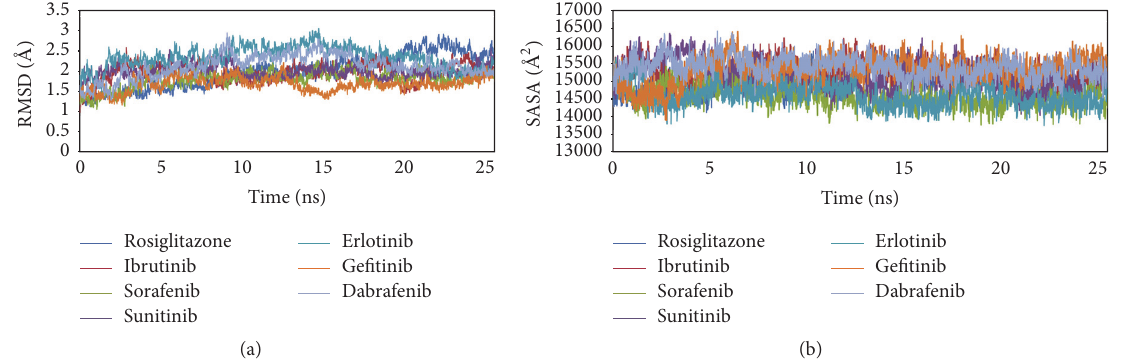
Figure 4: Molecular dynamics simulation of PPAR 𝛾 -ligand complexes. (a) RMSD of human PPAR 𝛾 backbone structure docked with KIs and cocrystalized compounds rosiglitazone in 25 ns simulation. (b) SASA of human PPAR 𝛾 -KI and of human PPAR 𝛾 -rosiglitazone complexes in 25 ns simulation.